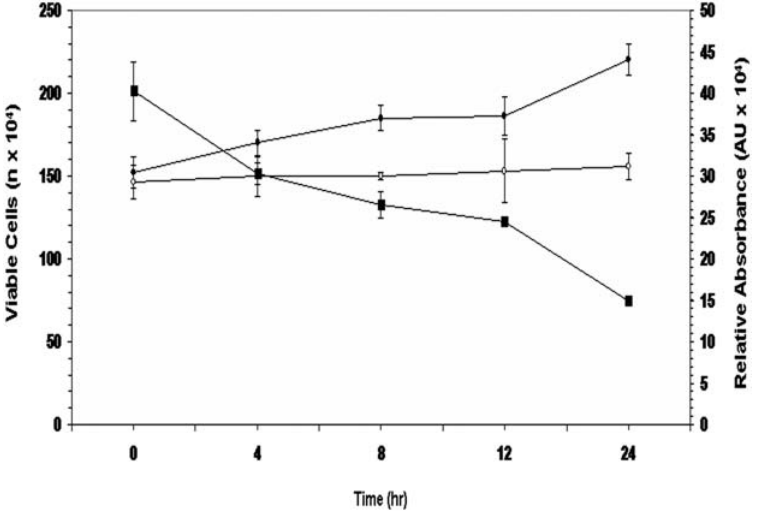
Figure 1. Lactate utilization by an astrocytic cell line. CCF-STTG1 cultures were supplemented with 2.5 mM lactate in serum free media. Lactate measurements were performed using HPLC (Reezex organic acid column) at various time intervals. Viable cell counts were performed using the Trypan Blue Exclusion Assay. N Corresponds to viable cell number of the astrocytic cells grown in serum free a -MEM + 2.5 mM lactate. # Corresponds to viable cell number of astrocytic cells grown in serum free a -MEM. & Corresponds to relative amount of lactate levels in the spent fluid (lactate cultures). n=3, mean 6 SD